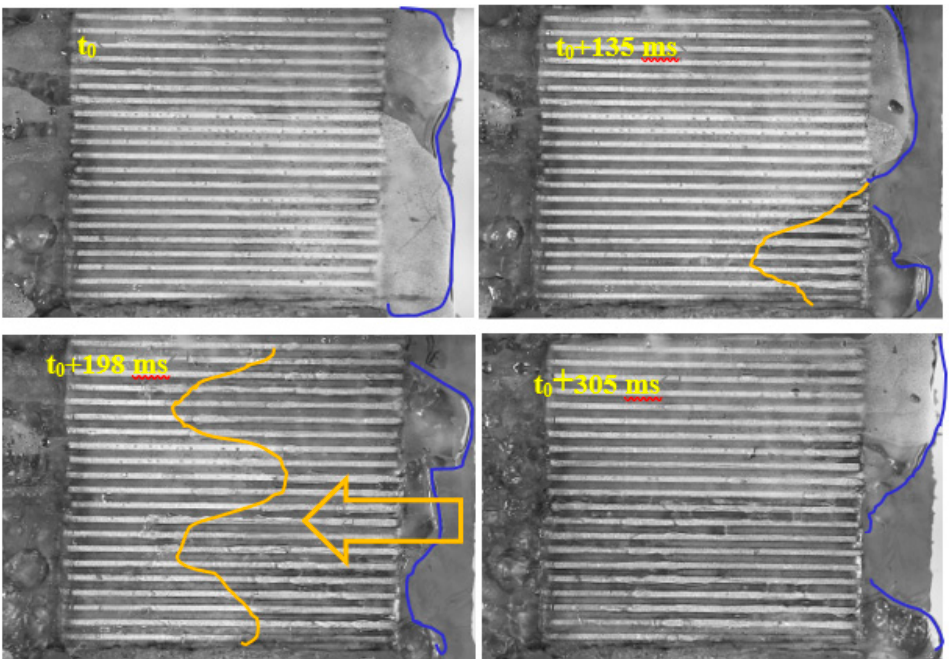
Figure 12. Pressure fluctuation curve of sample Q10-20% (q eff = 121.2 W/cm 2 ).